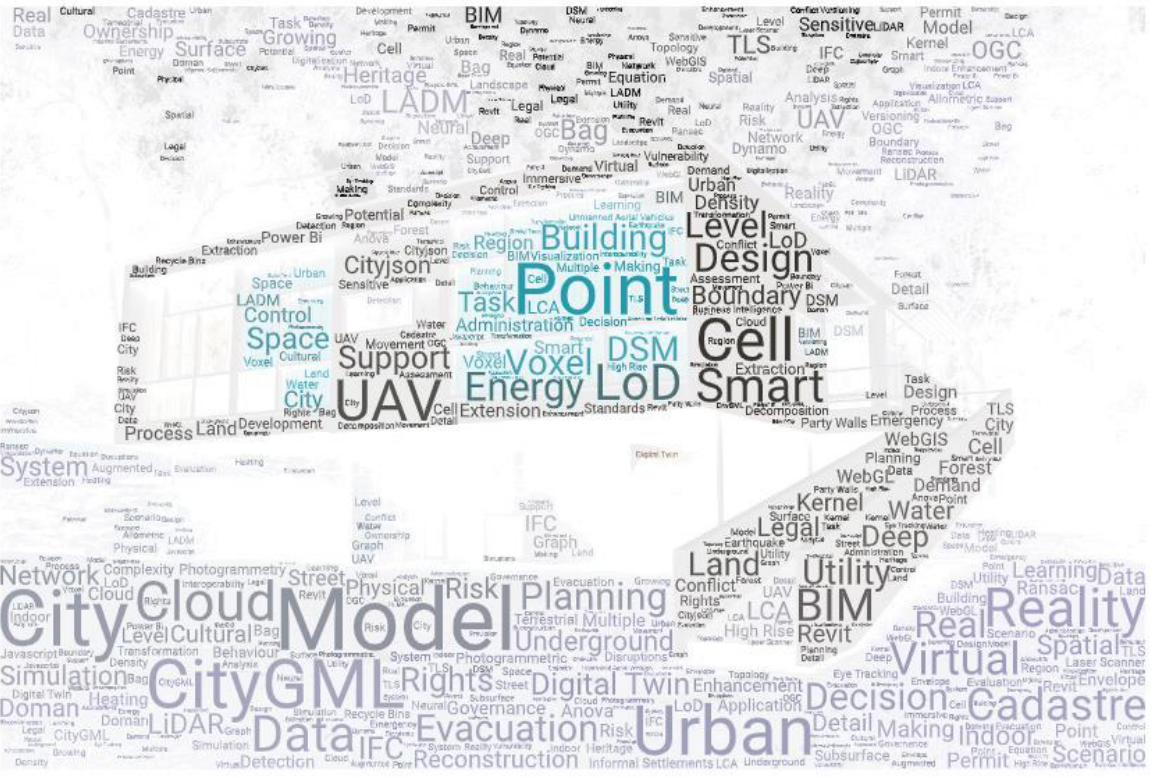
Figure 2: Visualisation of titles in the shape of Rose Seidler House, Wahroonga, NSW,